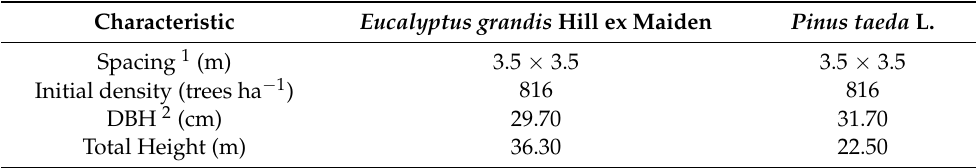
Table 2. Basic characteristics of trees and plantation area (mean of the three plots